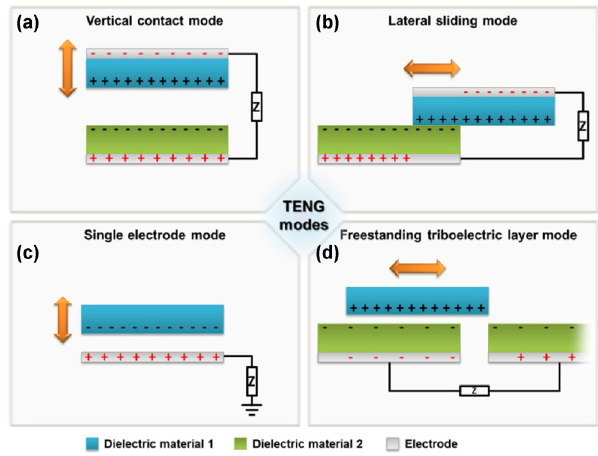
Fig. 2 The four fundamental modes of TENGs: (a) vertical contact mode, (b) lateral sliding mode, (c) single electrode mode, and (d) free-standing triboelectric layer mode [5, 22].